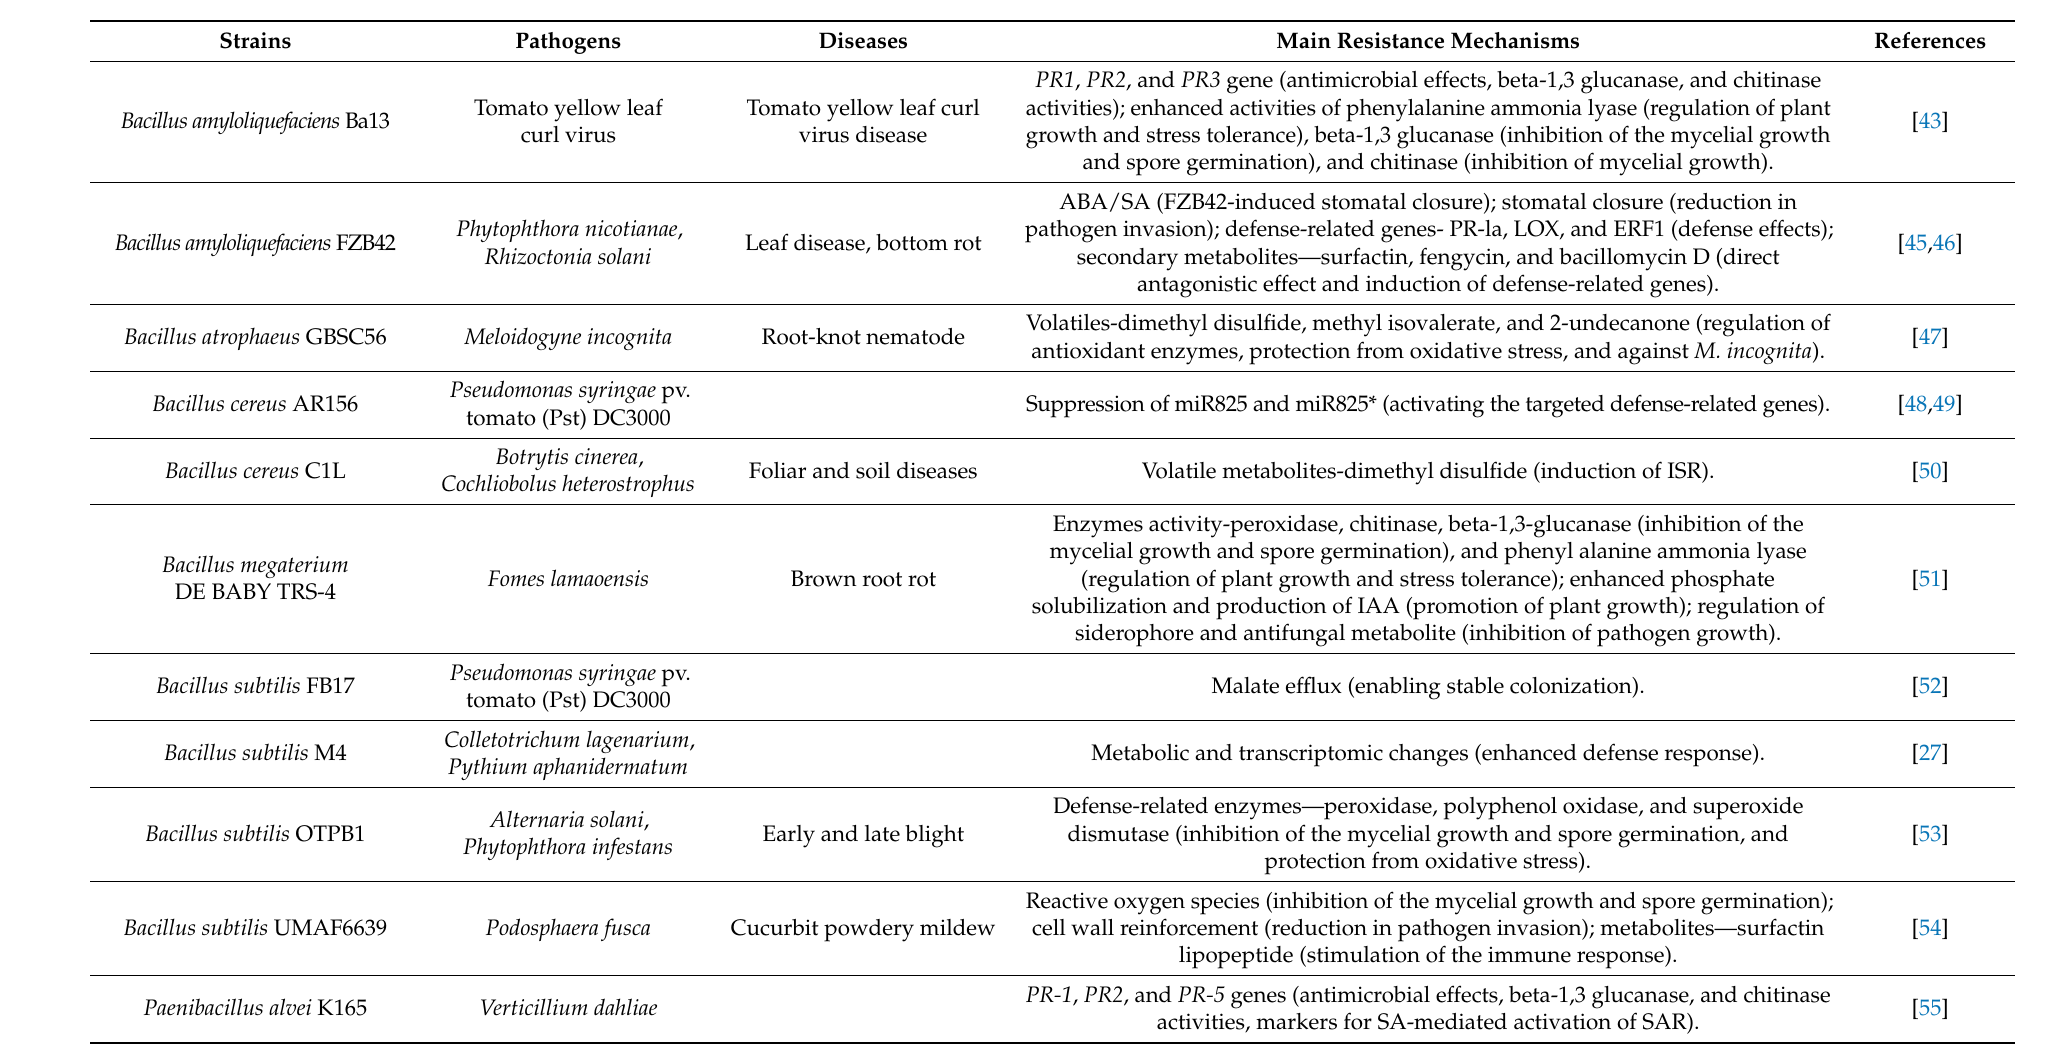
Table 1. Resistant mechanism of beneficial